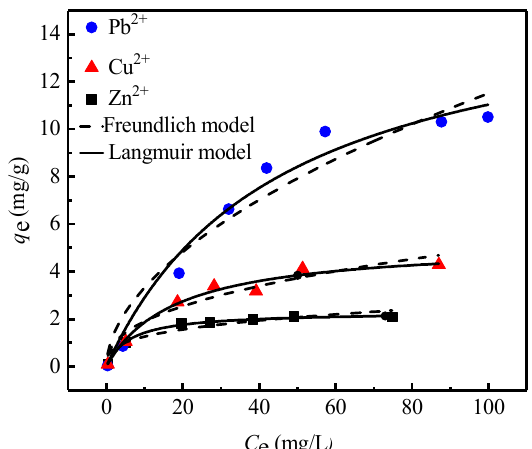
Figure 3. Adsorption isotherms of Pb 2 + , Cu 2 + , or Zn 2 + onto PPG-nZVI beads. Initial Pb 2 + , Cu 2 + , or Zn 2 + concentrations, 1–80 mg · L − 1 ; adsorbent dose, 5 g · L − 1 ; total solution volumes 50 mL; pH, 5.0; temperature, 25 ◦ C, and shaking time, 24 h. Table 2. Langmuir and Freundlich isotherm parameters for adsorption of Pb 2 + , Cu 2 + , and Zn 2 + by PPG-nZVI beads. Langmuir Model